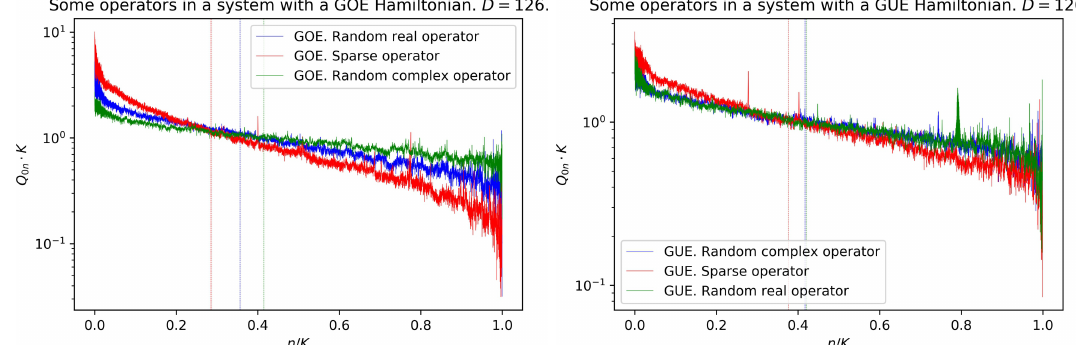
Figure 7. Long-time averaged operator wave packet and saturation value of K-complexity for dif- ferent operator choices and Hamiltonians drawn from two RMT ensembles. K-complexity saturation values are marked by vertical lines. The Hilbert space dimension chosen was D = 126 , and the obtained Krylov dimension saturates the upper bound [5], verifying K = D 2 − D +1 = 15751 . Left: GOE Hamiltonian. Operator choices: a sparse operator in the basis in which the Hamiltonian is drawn, a random real operator drawn from a Gaussian distribution in the same basis, and a random complex operator again drawn in the same basis. We observe that the random operators saturate at higher values as compared to the sparse operator, and within them, the one that breaks time- reversal (i.e. the complex one) has the highest complexity saturation value. Right: same choices of operator, but for a Hamiltonian drawn from GUE. In this case time reversal is anyway broken by the Hamiltonian itself, which is why the two random operators have quantitatively very similar features, both having a complexity saturation value slightly higher than that of the sparse